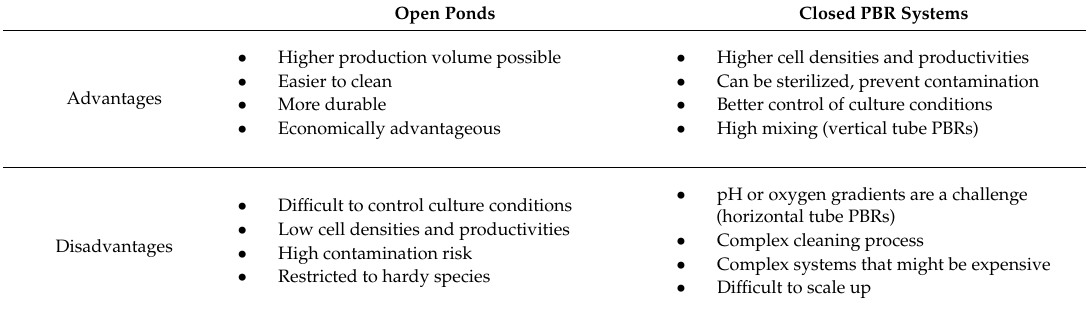
Table 8. Comparison between open and closed cultivation